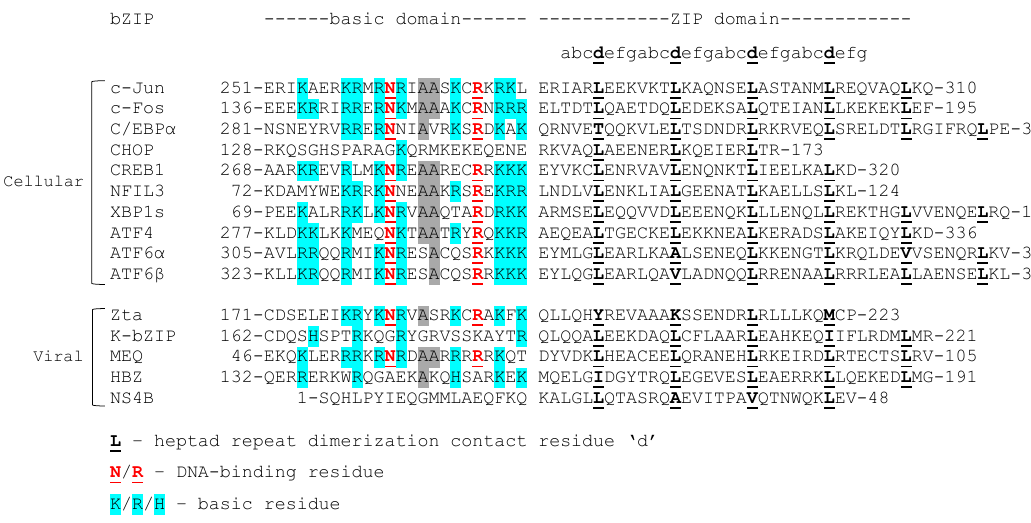
Figure 2. Sequence alignment of viral and human bZIPs. Amino acid sequences were obtained from the National Center for Biotechnology Information (NCBI) gene database and from the UniProt Knowledgebase. Colored residues represent consensus (red and gray) or basic (blue) amino acids. The viral bZIPs Zta, K-bZIP, MEQ, HBZ, and NS4B are expressed by the viruses Epstein-Barr virus, Kaposi’s Sarcoma associated herpesvirus, Marek’s disease virus, human T-lymphotropic virus, and hepatitis C virus, respectively. NCBI Accession Numbers: c-Jun NP_002219.1; c-Fos NP_005243.1;